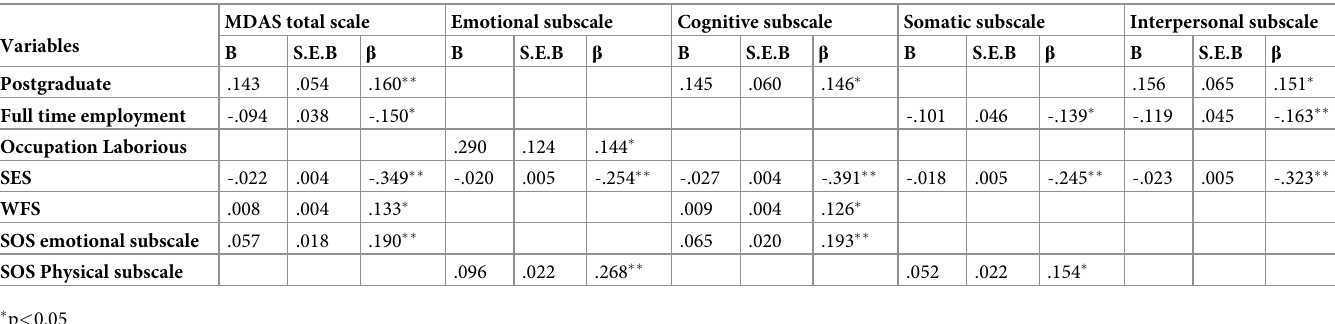
Table 4. Summary of hierarchical regression analysis for variables predicting total and each subscale of MDAS.